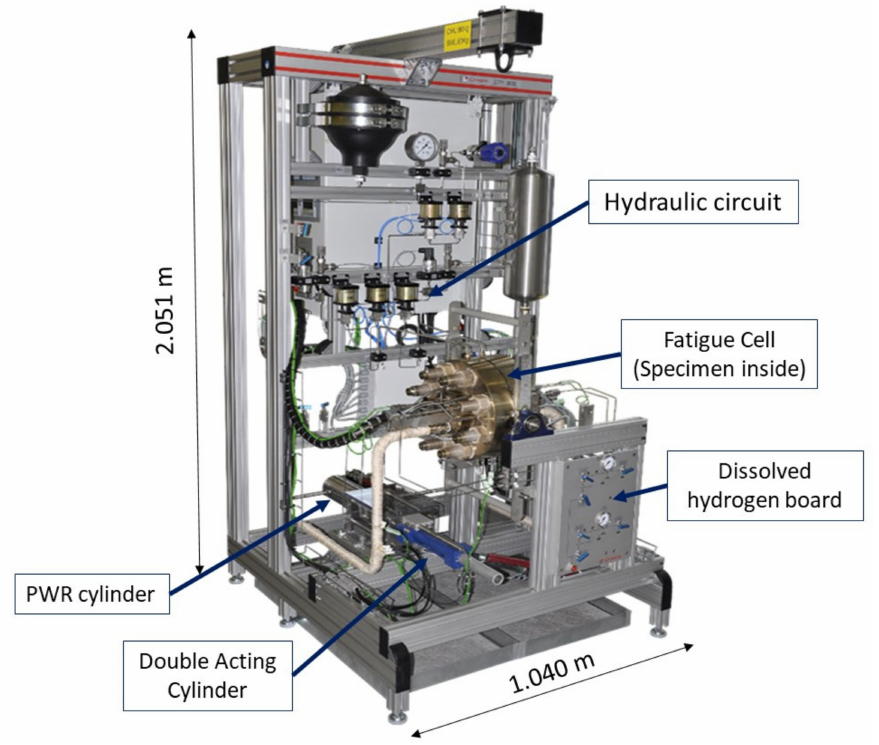
Figure 5. View of the new fatigue bending device